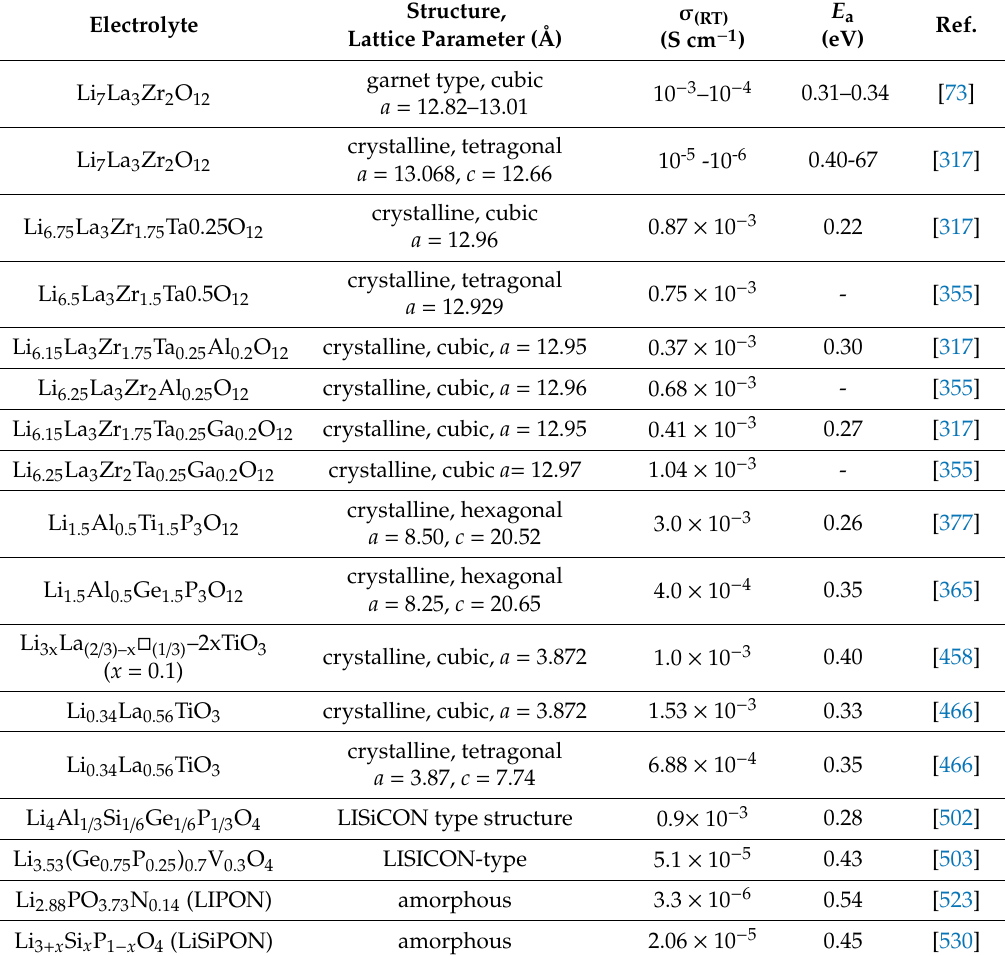
Table 3. Room temperature ionic conductivity σ (RT) and activation energy E a of oxide solid electrolytes.